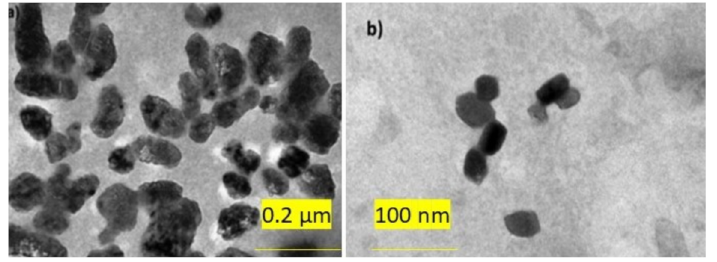
Figure 37. TEM images of CNS at ( a ) 500 ◦ C and ( b ) 600 ◦ C carbonization temperatures [149].